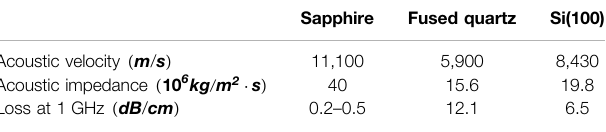
TABLE 4 | UHF ultrasonic transducer acoustic lens material